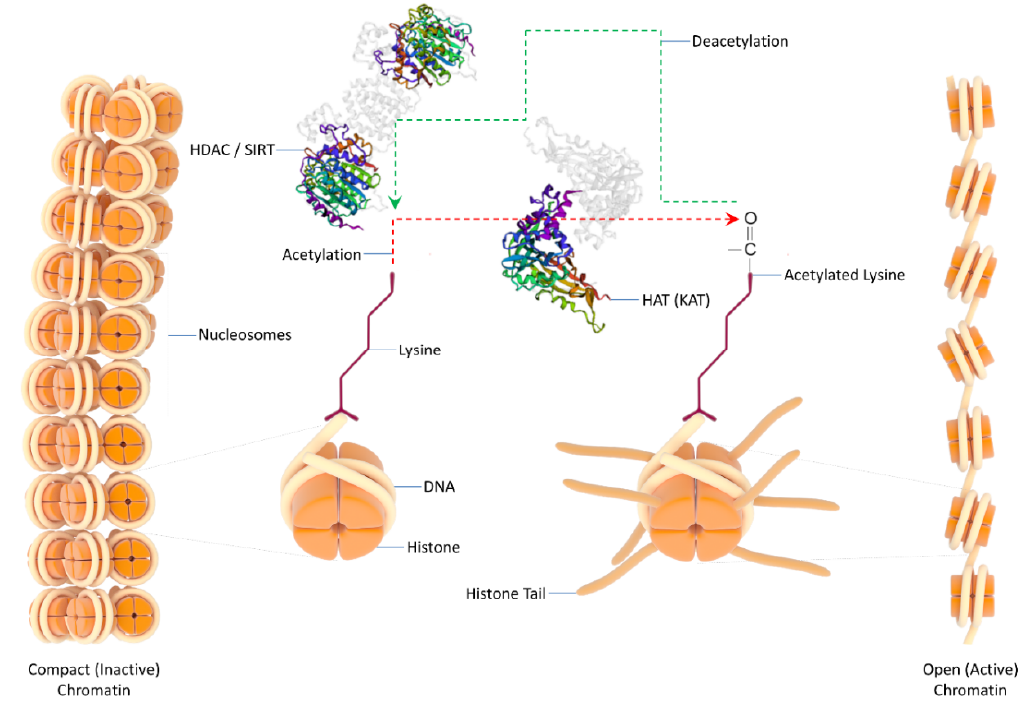
Figure 1. Graphic presentation of the acetylation and deacetylation processes. They can be implemented by the respective functions of HAT and HDAC enzymes, which regulate (among others) the acetyl-lysine load of nucleosomal histones, thus controlling the compact (transcriptionally inactive) or open (transcriptionally active) architecture of nuclear chromatin. HAT(1): PDB 2p0w; HDAC(1): PDB 4bkx [47,48].